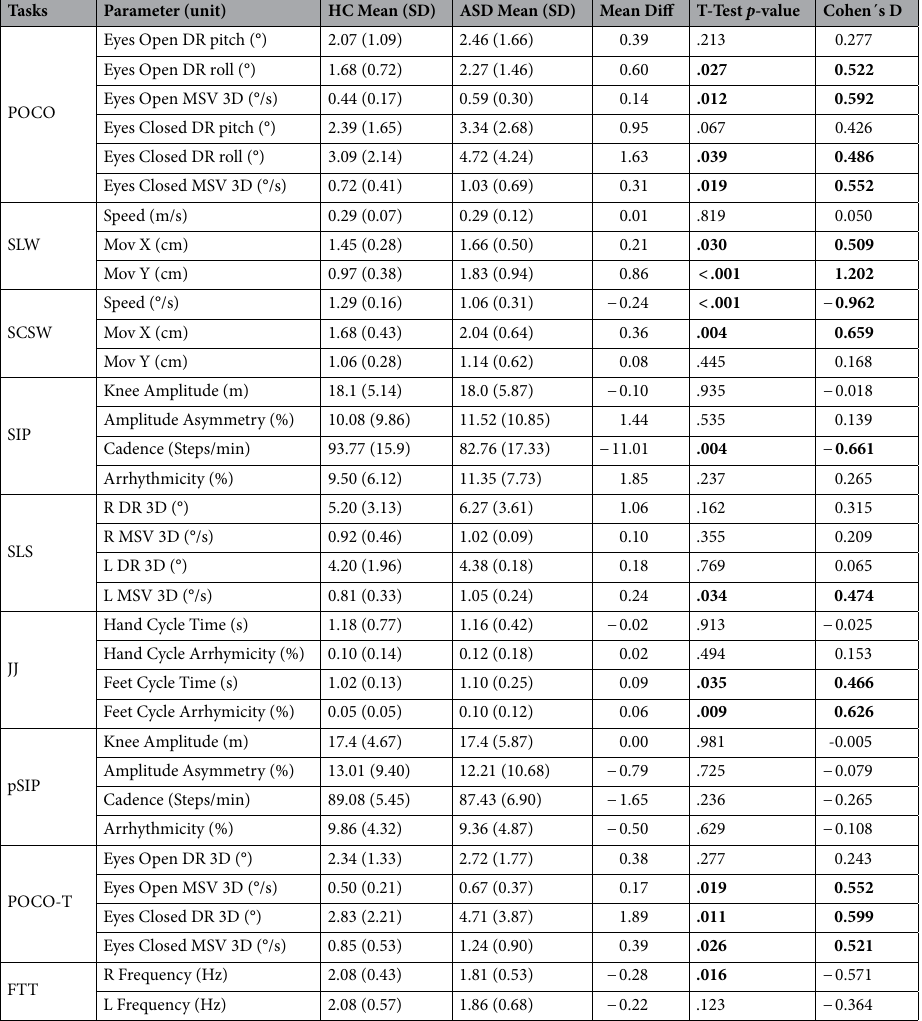
Table 4. Assessment of motor functions in adults with ASD in comparison to HC. HC = healthy controls, ASD = autism spectrum disorder, SD = standard deviation, Diff = difference, Sem = standard error of measurement, DR 3D = deflection range in 3D, MSV 3D = mean sway velocity in 3D, Mov X = movement deviation in mediolateral direction, Mov Y = movement deviation in anteroposterior direction at hip level, R = right, L = left, Hz = Hertz, POCO = postural control stance, POCO-T = postural control tandem stance, SLS = single leg stance, SLW = line walk, SCSW = walk at a subjectively comfortable speed, SIP = stepping in place, pSIP = paced stepping in place, JJ = jumping jack, FTT = finger tapping test. For description of movement tasks see Table 1. Bold values show p -value smaller than